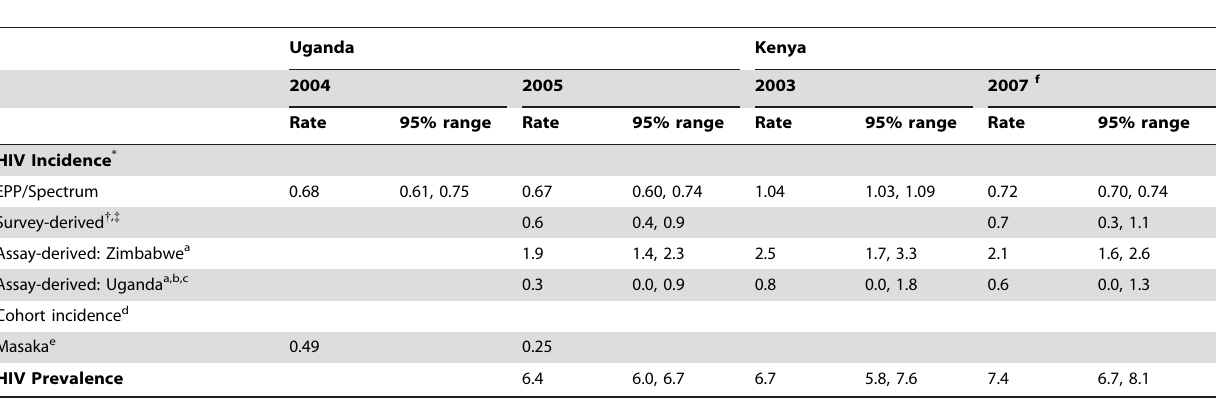
Table 1. HIV Incidence and Prevalence Rates in the Year of the National Survey, by Estimation Method, Kenya and